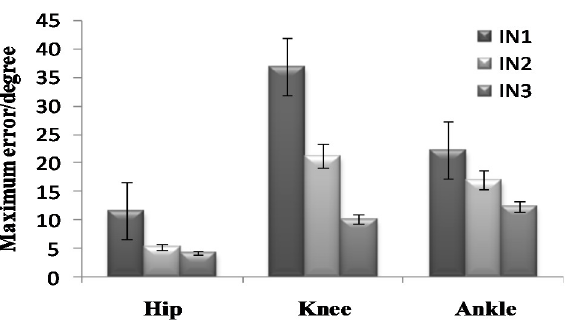
Figure 22. Maximum error of the prediction results in the going downstairs process.